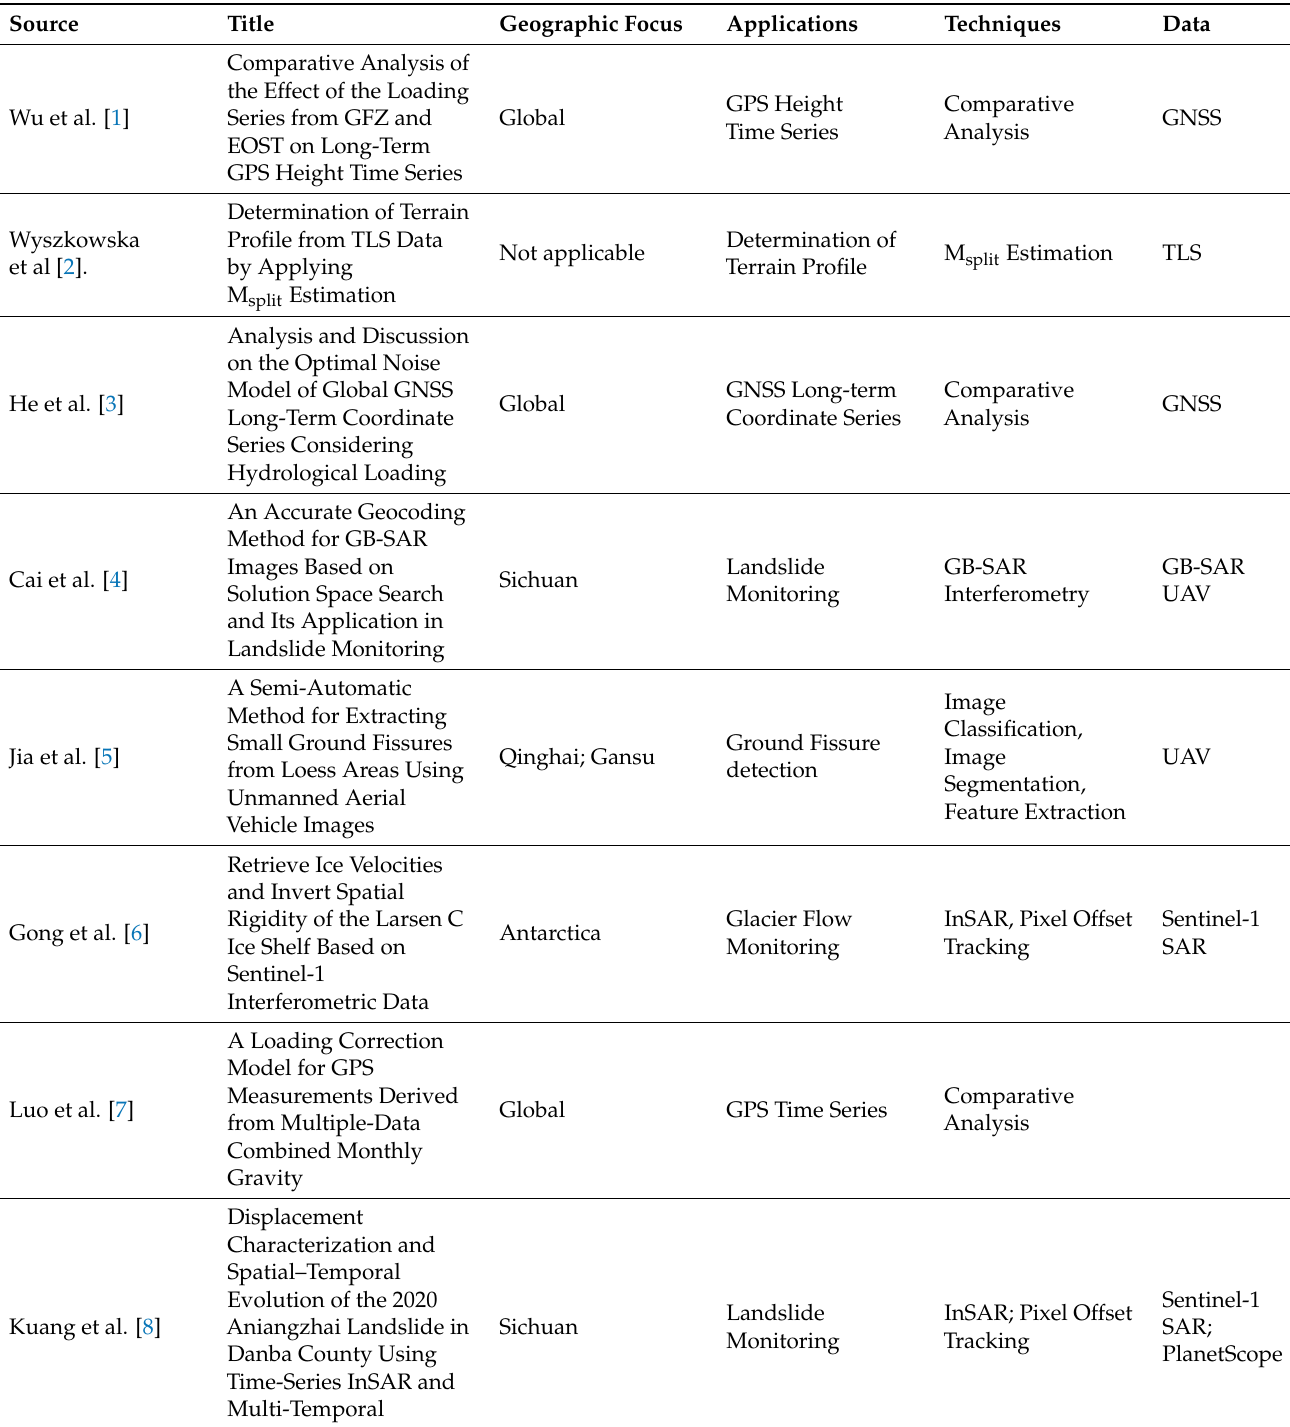
Table 1. Overview of geodetic monitoring methods, data, and geohazard types that are dis- cussed in the fourteen research papers composing the Special Issue “Geodetic Monitoring for Land Deformation” of Remote Sensing . Papers are sorted in ascending order according to